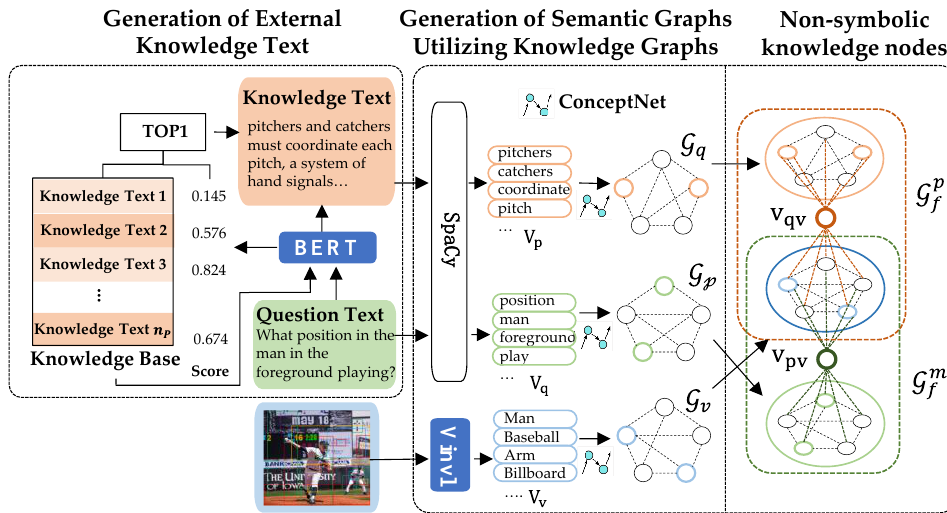
Figure 2. Development of the multi-modal semantic graph.